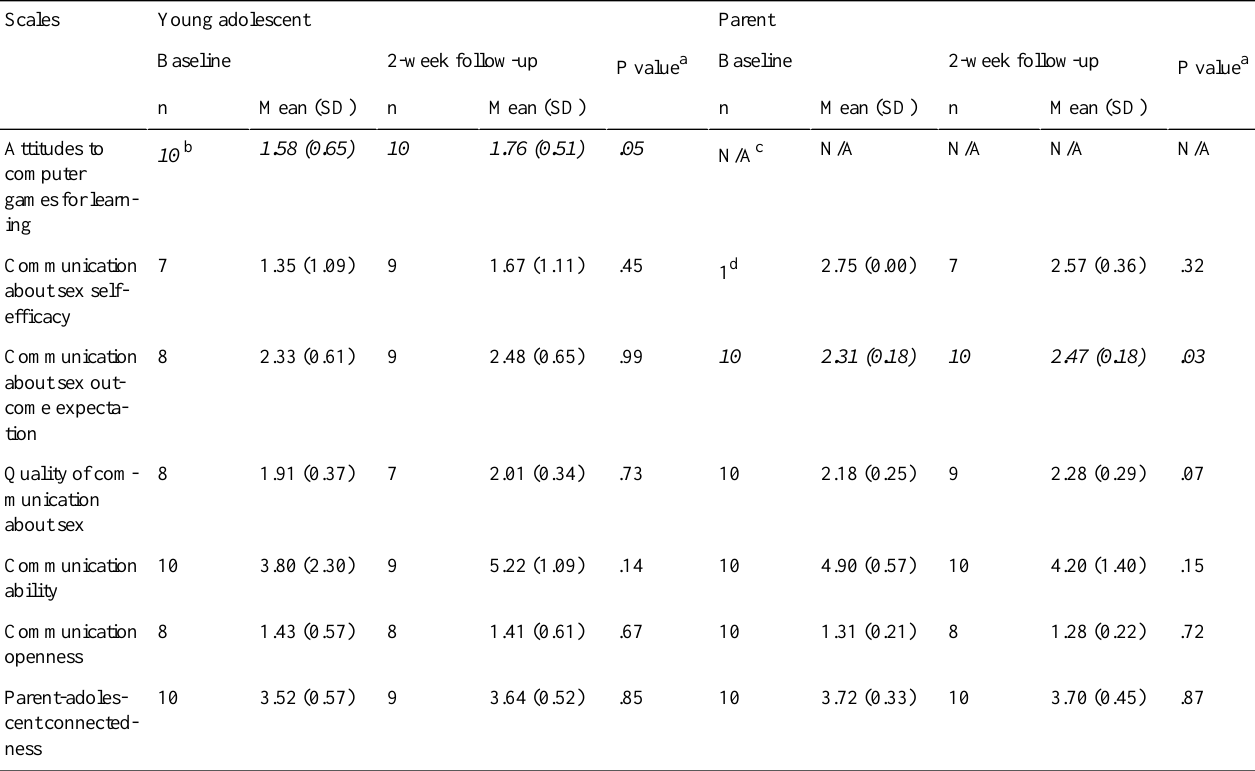
Table 5. Young adolescent change in dyadic communication following exposure to Secret of Seven Stones 2-level prototype ParentYoung